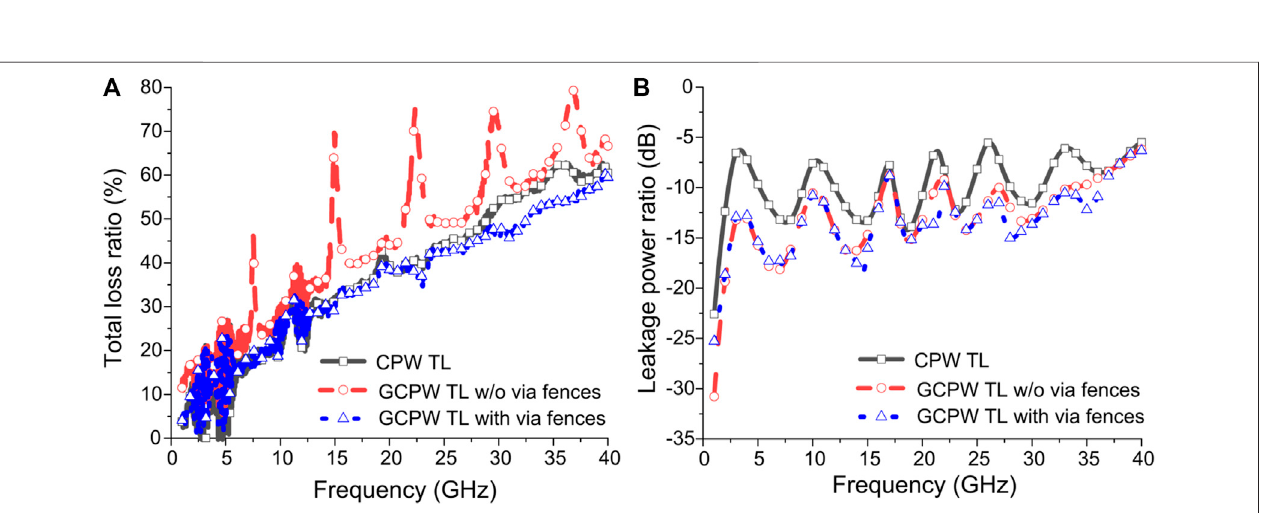
Frontiers in Communications and Networks |